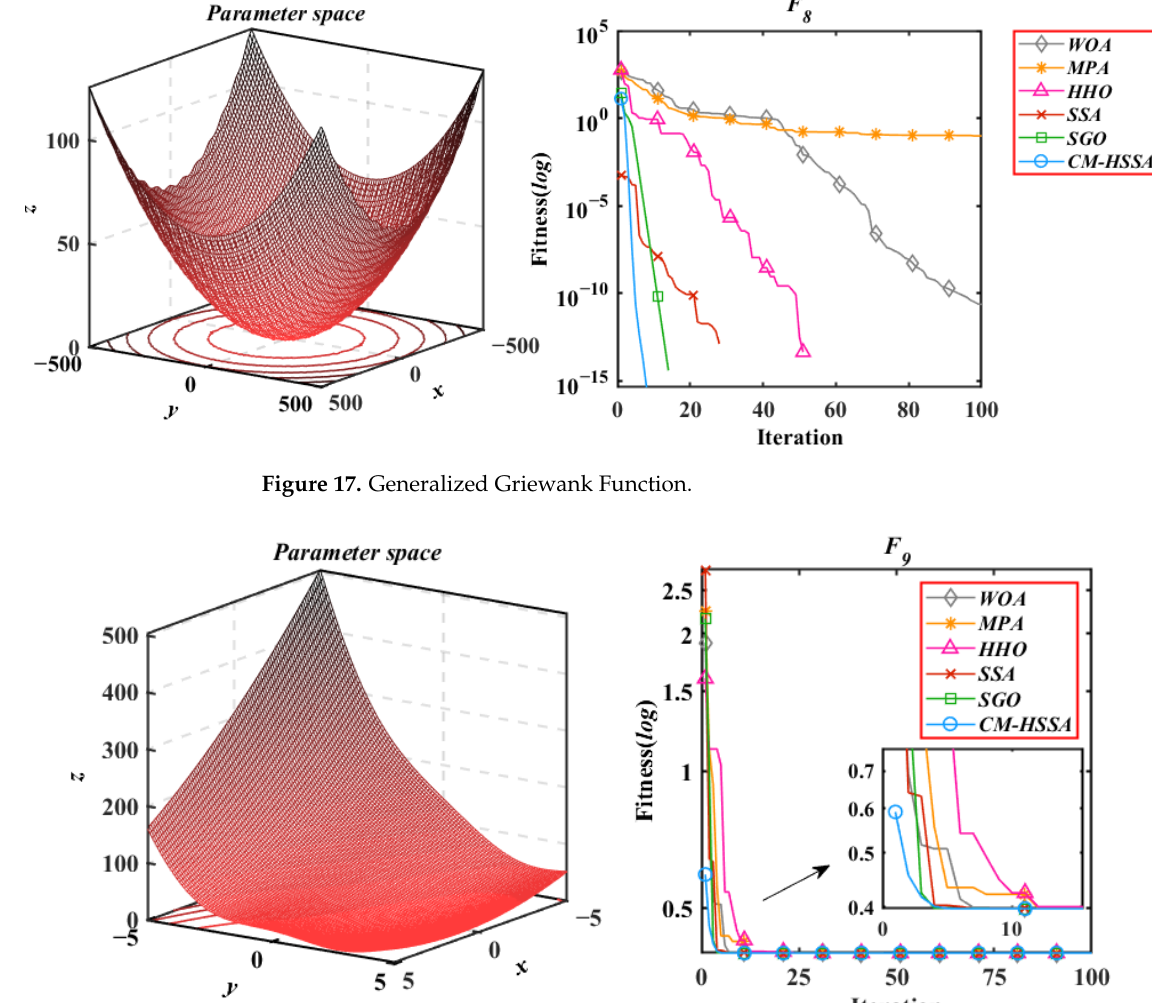
Figure 18. Branin Function.